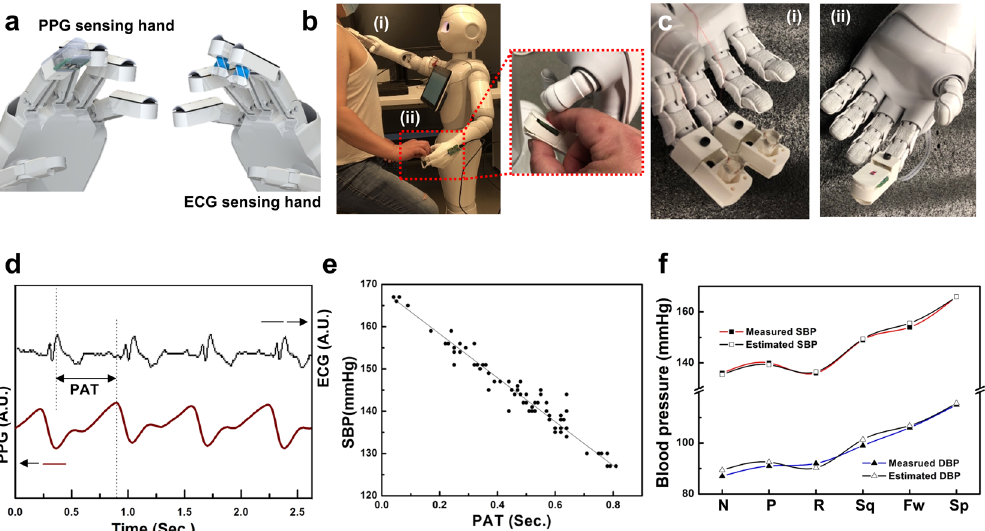
Fig. 6 Blood pressure (BP) monitoring sensing robot system. a Schematic of the robot hand equipped with PPG sensor on the left and ECG sensor on the right. b The actual images of the sensing process through human – robot interaction for BP measurement. All photos are produced under the agreement of the participant. c Their actual photos of ECG (i) and PPG (ii) sensing robot hands. d The overlaid ECG and PPG graphs to obtain pulse arrival time (PAT). e The diagrams of monitored systolic blood pressure (SBP) obtained from a sphygmomanometer with their corresponding PAT. From the diagram, the linear fi t model is used to obtain the estimated SBP. f Comparison of measured and estimated SBP and diastolic blood pressure (DBP) at different postures or exercises (N: Normal, P: Push-up, R: rest, Sq: Squat, Fw: fast walking, and Sp: